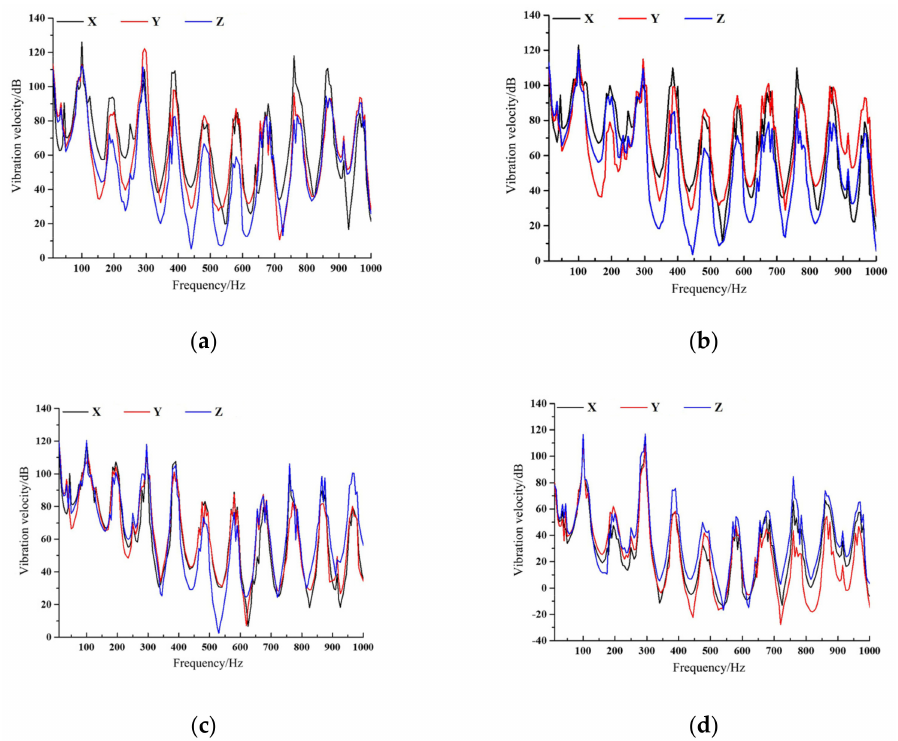
Figure 18. The frequency spectrum of the vibration of the pump unit caused by electromagnetic excitation: ( a ) export flange; ( b ) import flange; ( c ) connecting plate; ( d )